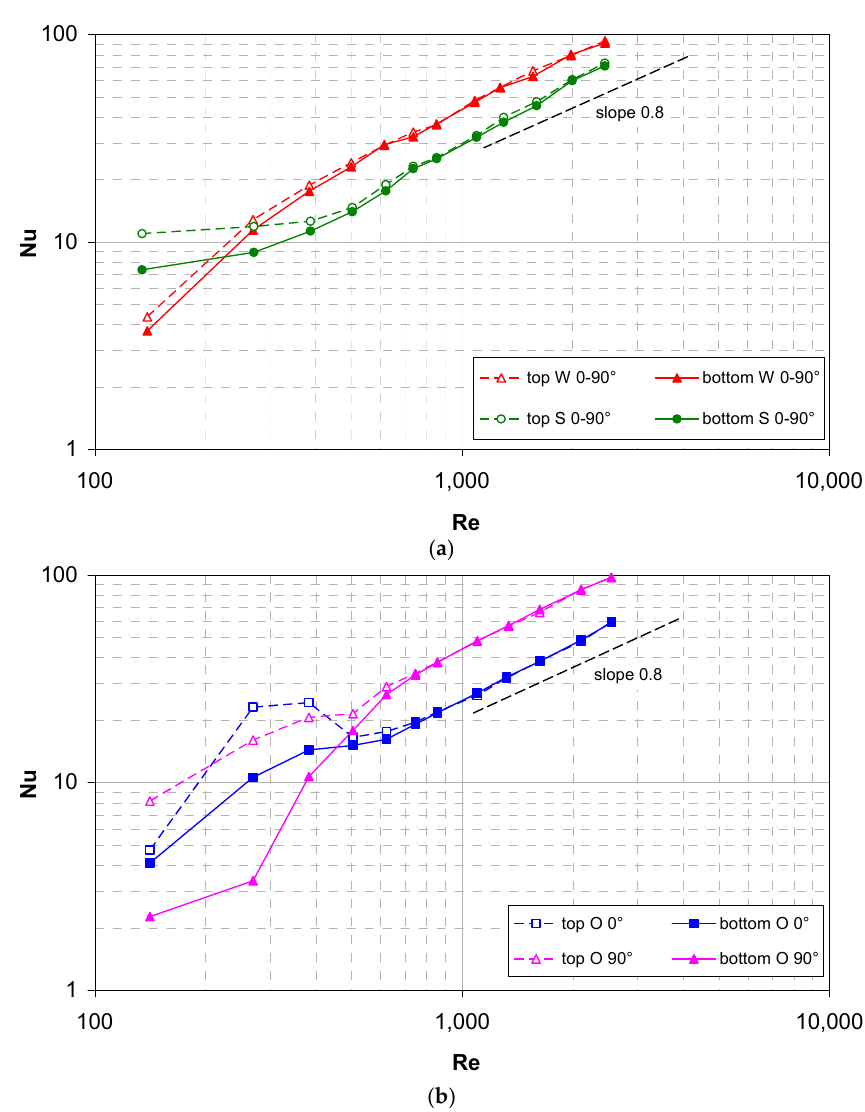
Figure 8. Experimental mean Nusselt number as a function of the Reynolds number on the top and bottom walls for a flow attack angle of 0° or 90°. ( a ) Woven and spheres geometries; ( b ) overlapped geometry.